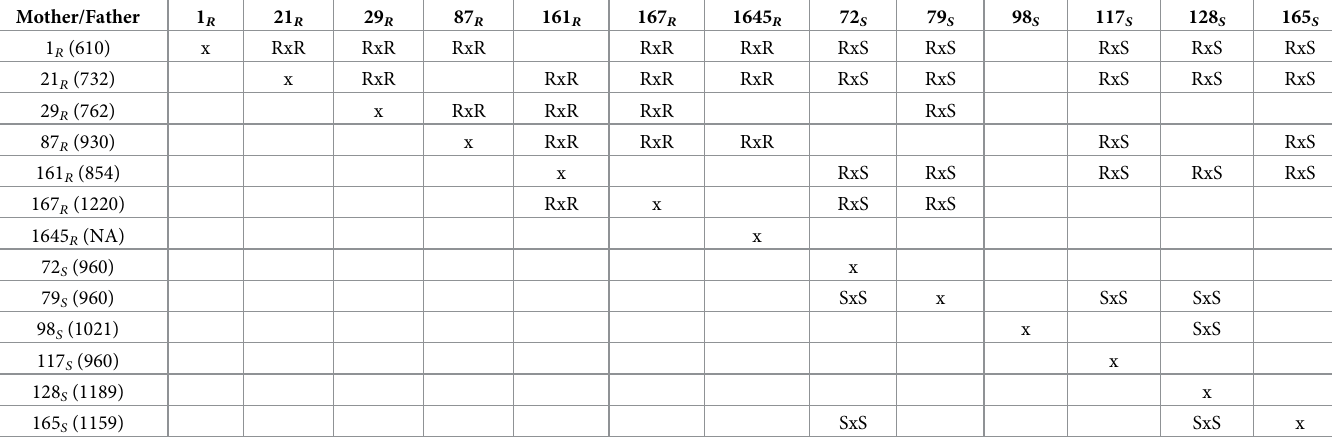
Table 1. Mating design representing 42 controlled crosses (families) used in this study.